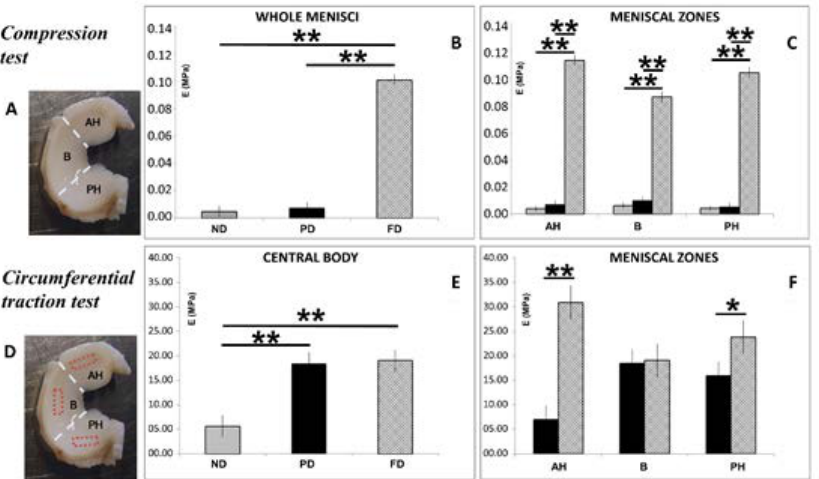
Figure 5. Biomechanical results from compression ( A ) and traction ( D ) tests. Compression test results for pooled ( B ) and subdivided samples ( C ). Circumferential traction test results for pooled ( E ) and subdivided ( F ) samples. AH: anterior horn; B: body; PH: posterior horn. Values with ** and * differ for p < 0.01 and p < 0.05,